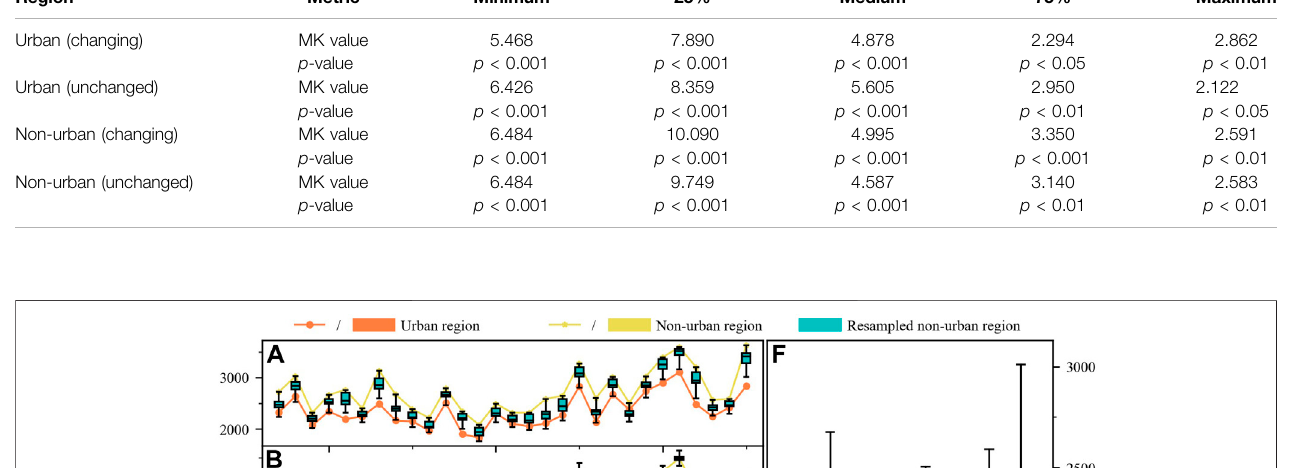
TABLE 4 | The MK trend test for annual TP in different percentiles of the YDM during 1992 – 2020. Region